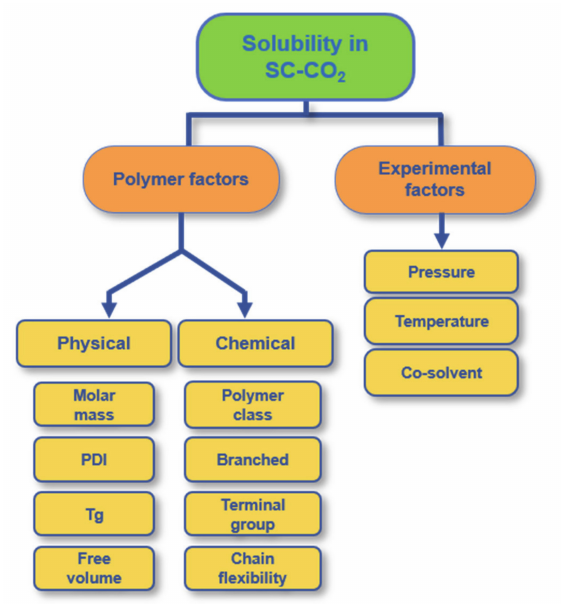
Figure 2. Parameters that influence the solubility of a polymer in SC-CO 2 divided into the two main categories “polymer factors” and “experimental factors” with their illustrated